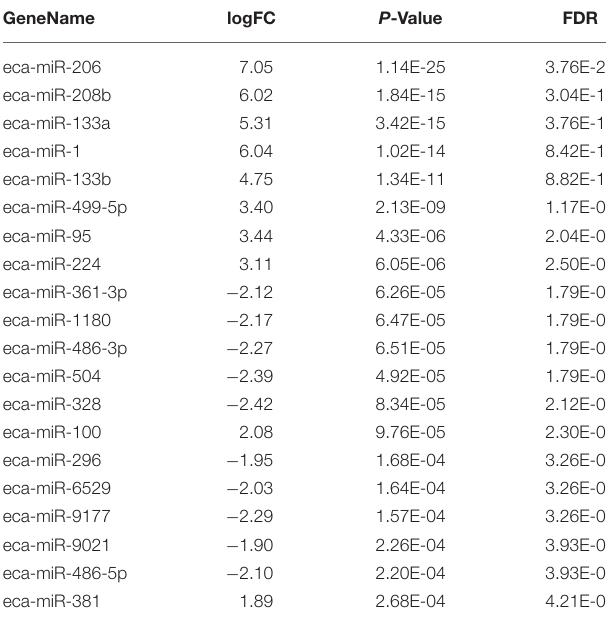
TABLE 3 | Quantities of RNAs listed per abundance, in number of counts and in transcripts per million kilobases (TPM). Grouping Quantity (all samples)